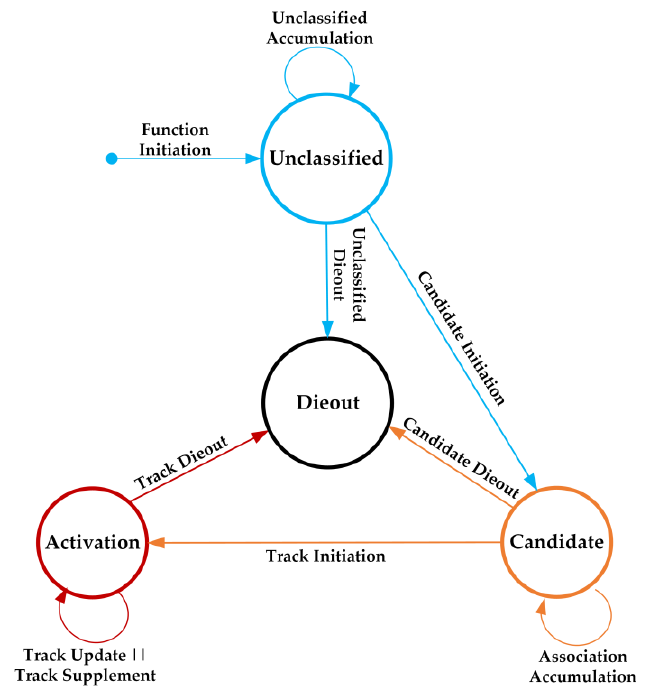
Figure 1. Finite state machine diagram.